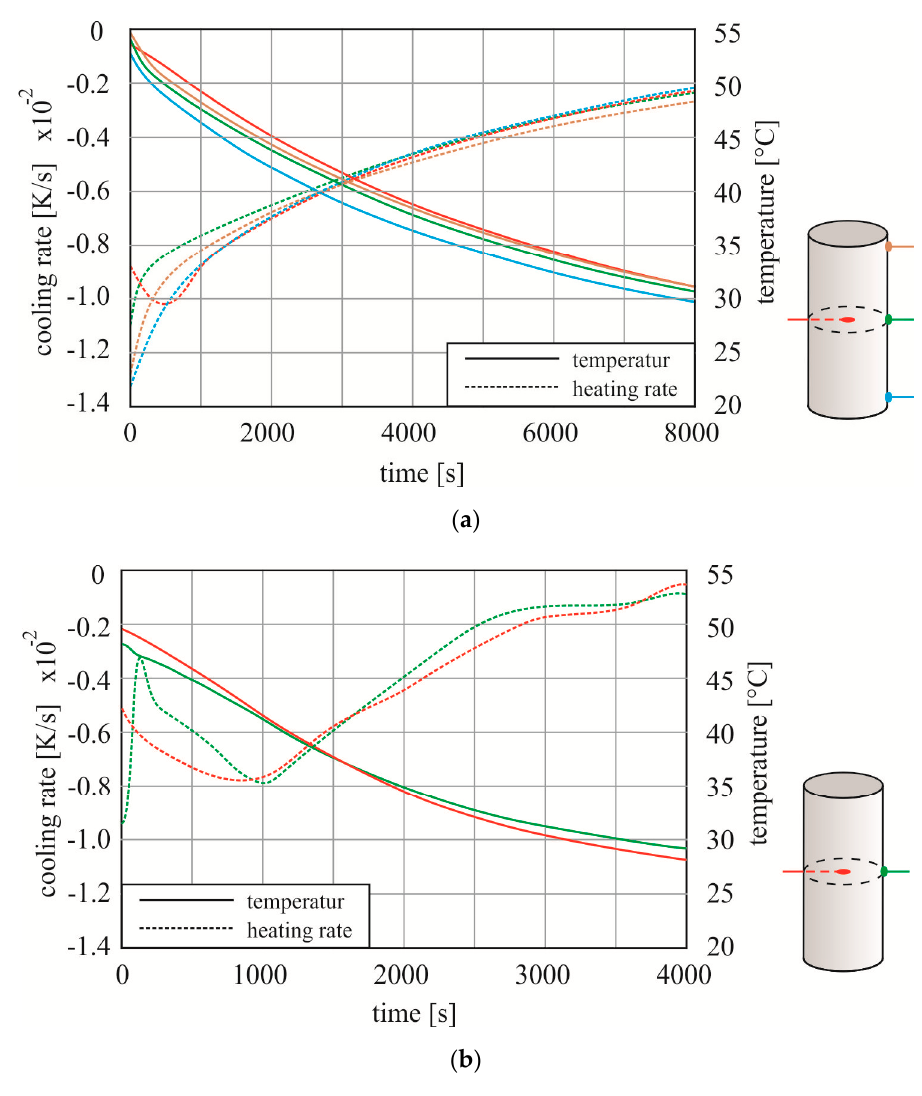
Figure 6. ( a ) Cooling of the PK 4T test specimen between the thermal insulation plates; ( b ) data of the sensors in the middle of the height of PK 2T in detail.